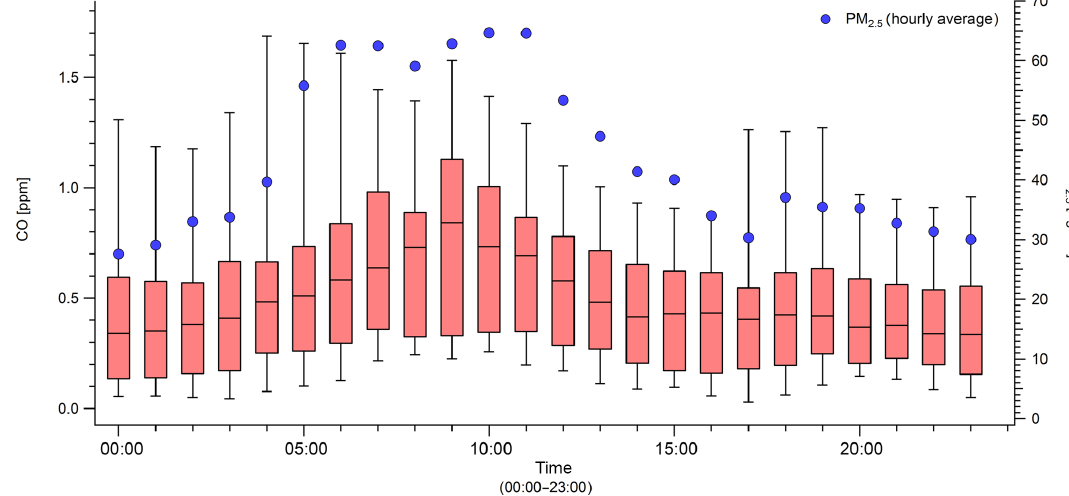
Figure 7. Diurnal plot of CO and PM 2 . 5 , shown for the entirety of the monitoring period.